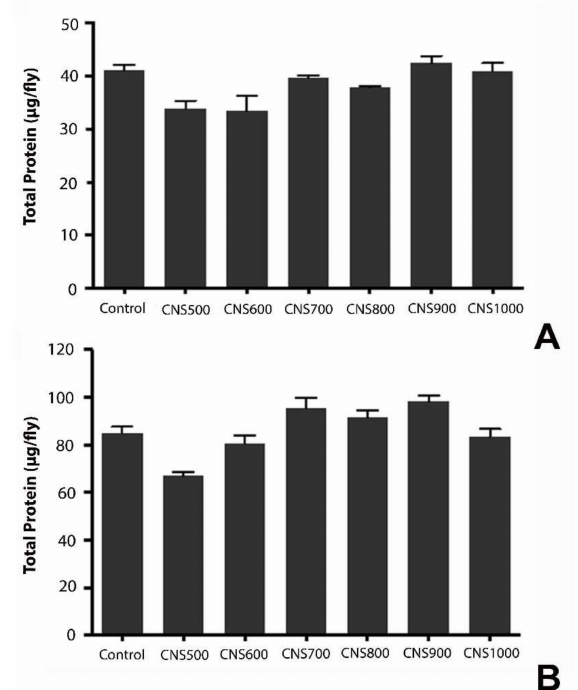
Figure 10. Estimation of glucose in response to dietary exposure to CNS500, CNS600, CNS700, CNS800, CNS900, and CNS1000 CNSs for 25 days at 1000 µ g/mL dose in ( A ) male and ( B ) female flies. The values are represented as mean ± SEM and statistical significance was set at p < 0.05 when compared to control (n = 3 and 25 flies per treatment group).